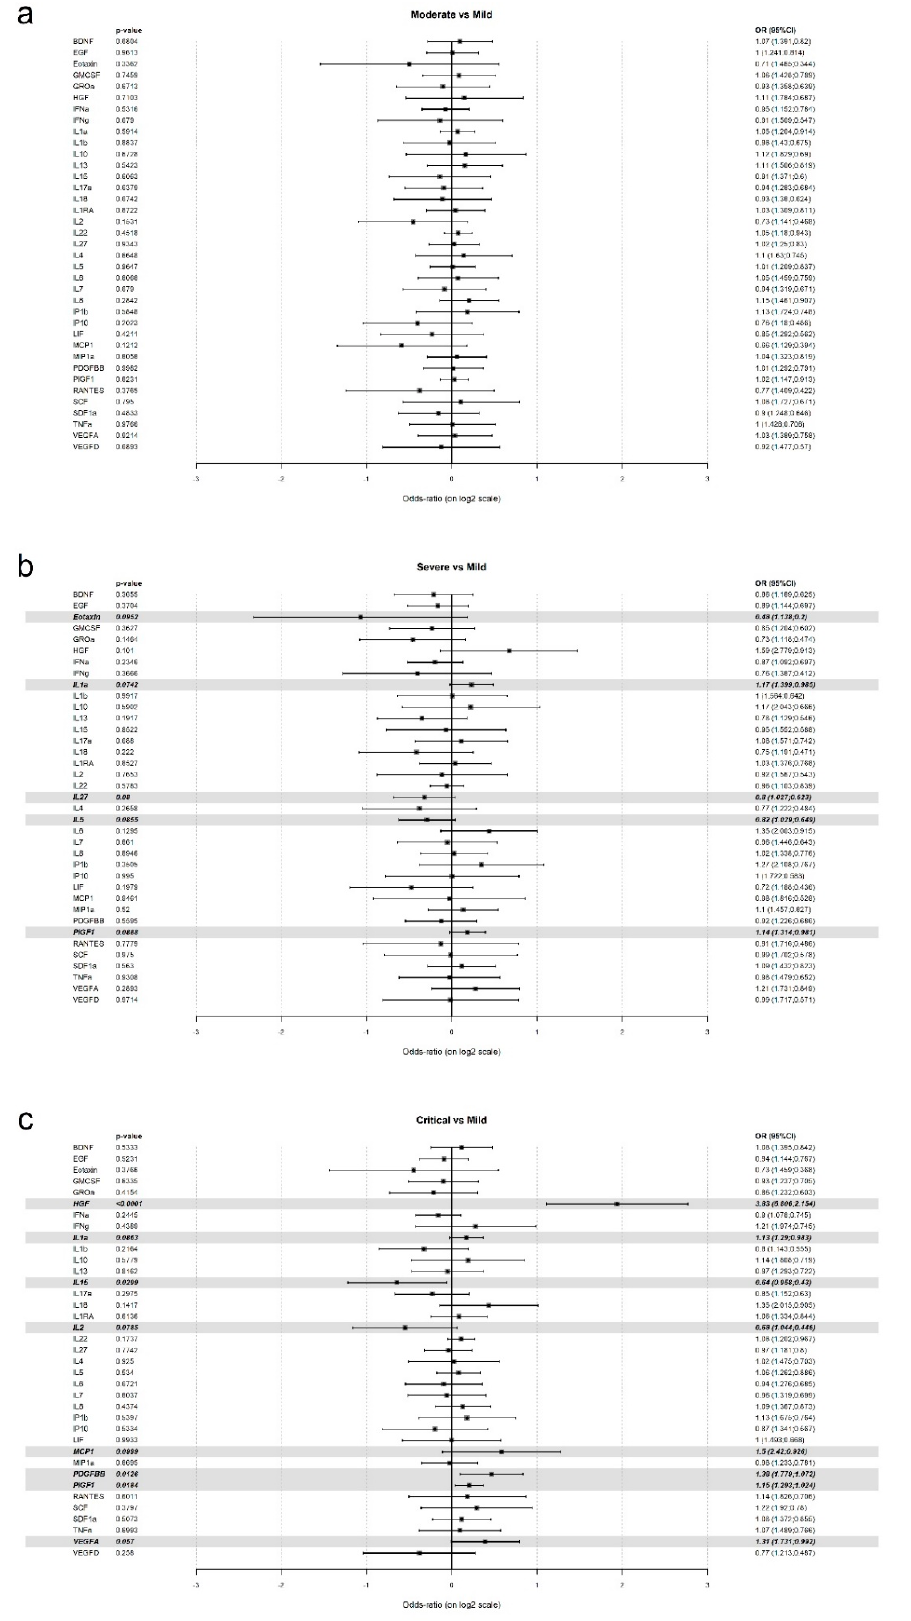
Figure 1. Individual multinomial models using the mild group as a reference. ( a ) Moderate. ( b ) Severe. ( c ) Critical.